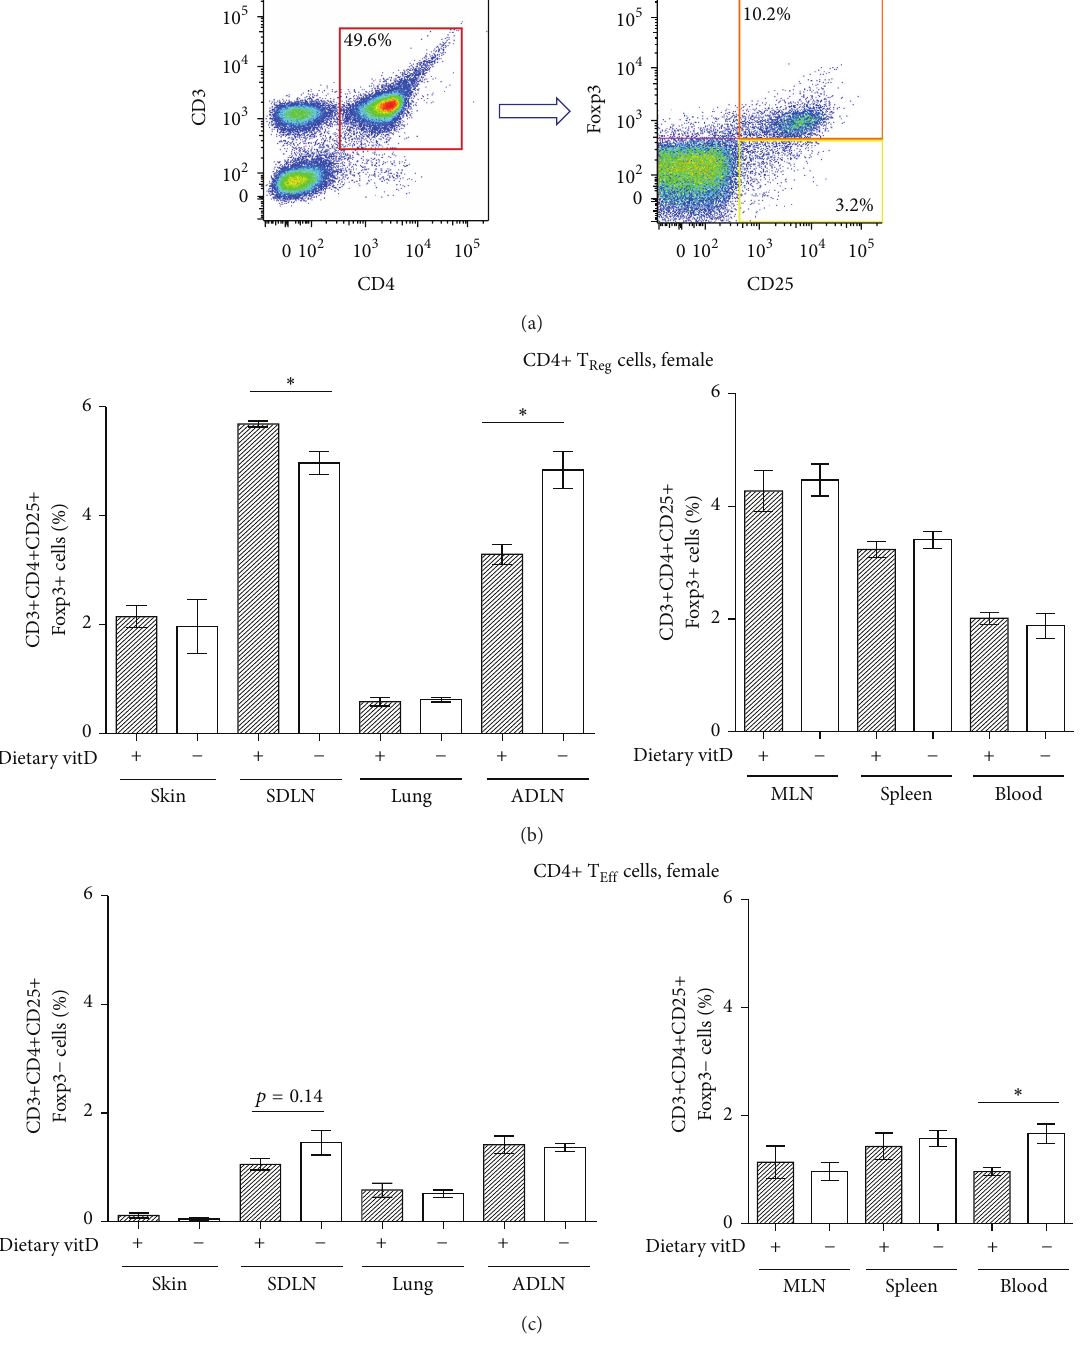
Figure 2: Dietary vitamin D 3 increased the percentage of Foxp3+ T cells in the SDLN. Female offspring born to vitamin D 3 - (vitD-) Reg replete (+) or vitamin D 3 -deficient ( − ) BALB/c mothers were maintained on the vitamin D 3 -replete or vitamin D 3 -deficient diets (resp.). (a) cells, orange) or CD3+CD4+CD25+Foxp3 − The FACS gating strategy for determining the percentage of CD3+CD4+CD25+Foxp3+ (T Reg cells, yellow) cells in skin, SDLN, lung, ADLN, MLN, spleen, and blood. Representative plots from a MLN sample are shown. For (T Eff all tissues, a gate was used to exclude red blood cells using forward and side scattering properties of cells prior to selection of the various cells and T cells (resp.) in various tissues. Data are shown as mean ± SEM for 6 T cell populations. (b) and (c) The percentage of T Reg Eff mice/treatment with results combined from two experiments; ∗ 𝑝 < 0.05